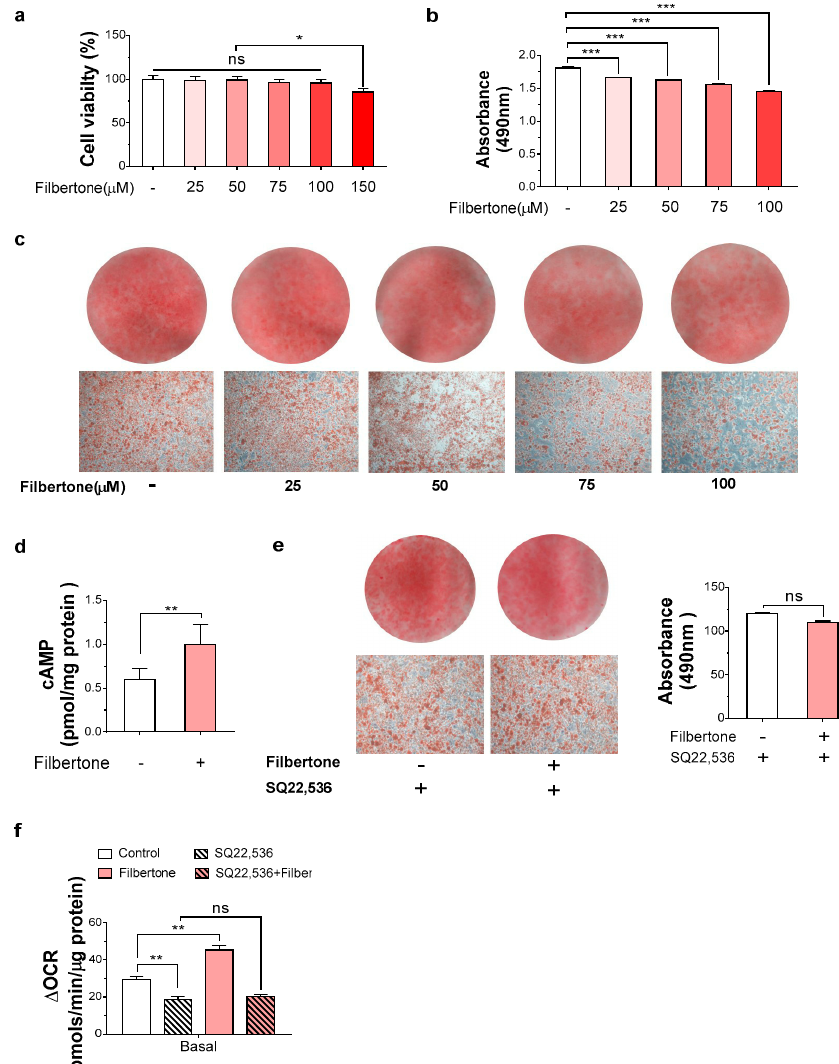
Figure 6. Filbertone reduces triglyceride accumulation in 3T3-L1 cells via the cAMP pathway. ( a ) The percentage of viable cells was performed by an MTT assay. ( b , c ) Oil Red O (ORO) staining of 3T3-L1 cells after stimulation with filbertone at the indicated concentration. ( d ) The cAMP concentration in 3T3-L1 cells treated with or without 50 µ M filbertone. ( e ) ORO staining of 3T3-L1 cells treated with filbertone (50 µ M) in the presence or absence of the adenylate cyclase inhibitor, SQ22,536 (100 µ M). Spectrophotometric data for ORO-stained adipocytes are means from three independent experiments for each group, and representative photomicrographs ( × 200) are shown. (f) The oxygen consumption rate (OCR) was determined in differentiated 3T3-L1 cells under basal conditions. * p < 0.05, ** p < 0.01, and *** p < 0.001, between the groups. Values are means ± SEM.